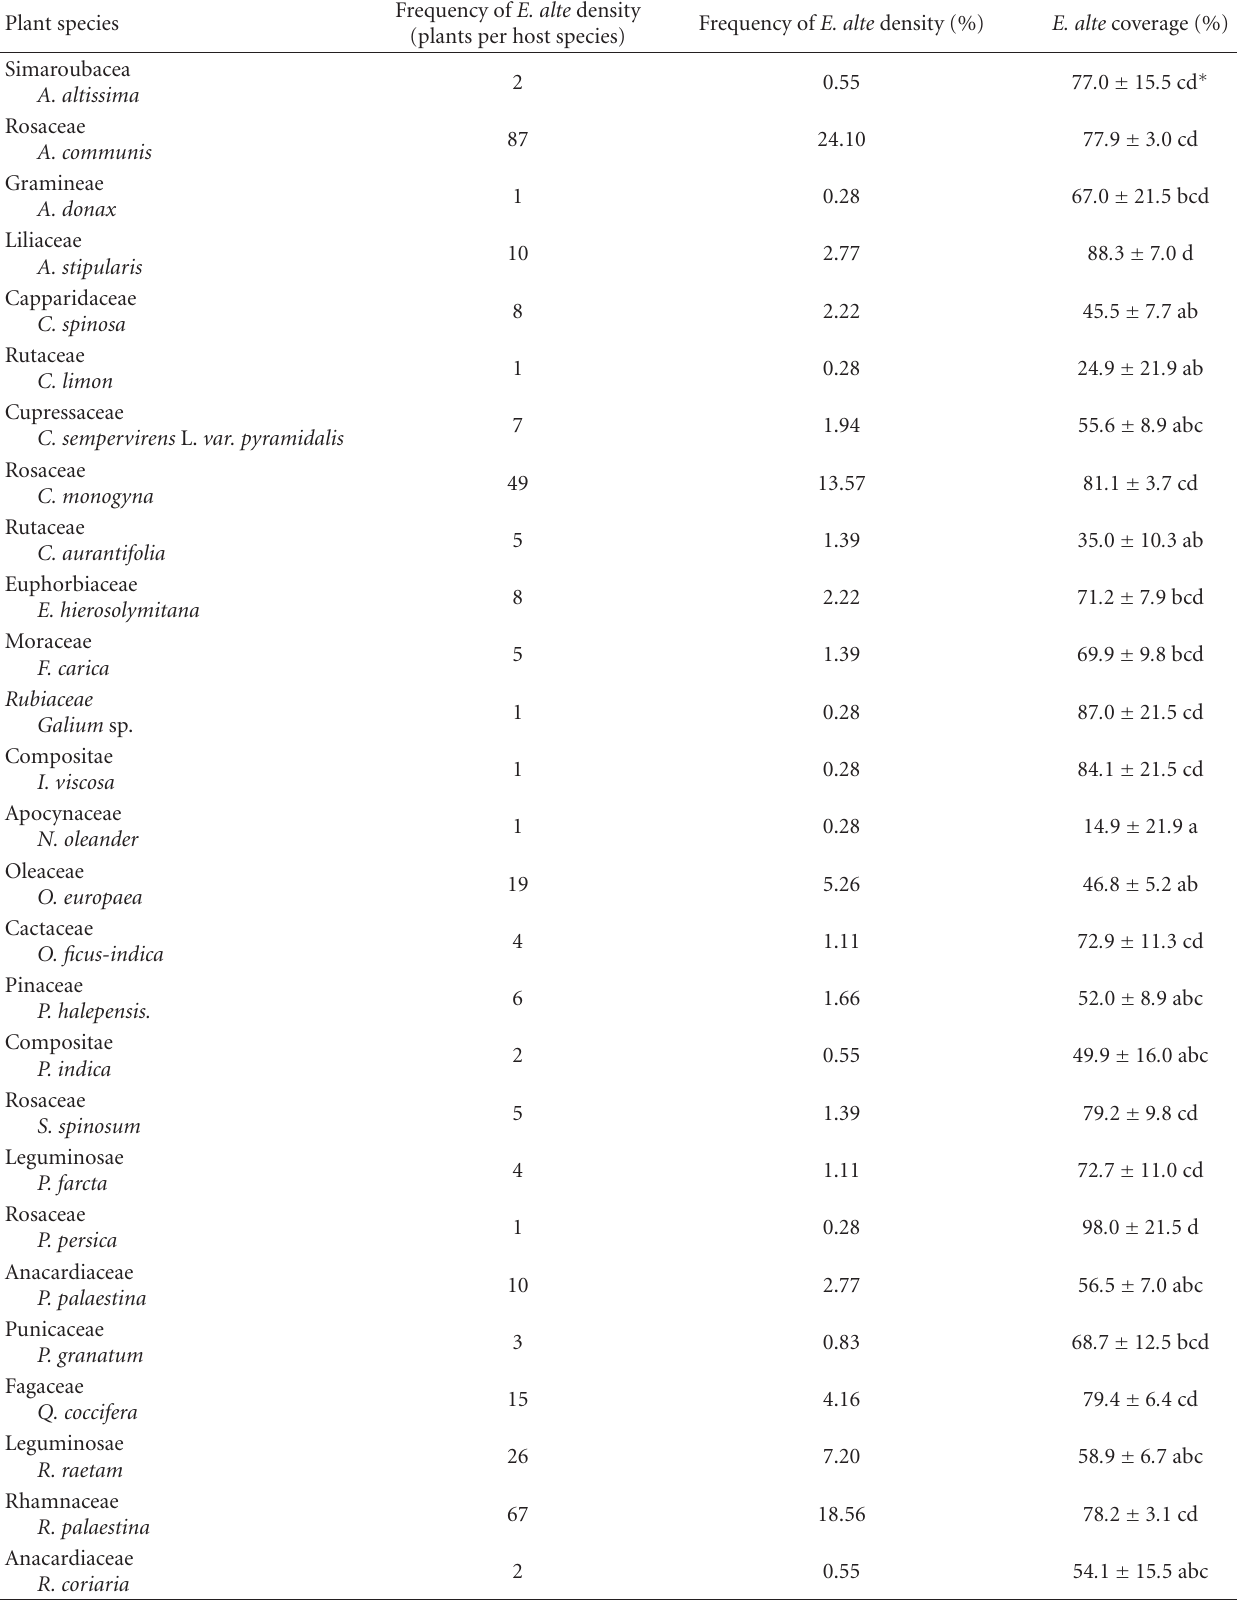
Table 3: Total number and frequency of E. alte plants per host plant species attacked and coverage percentage on host plant in six randomly selected representative sites in Jordan late in